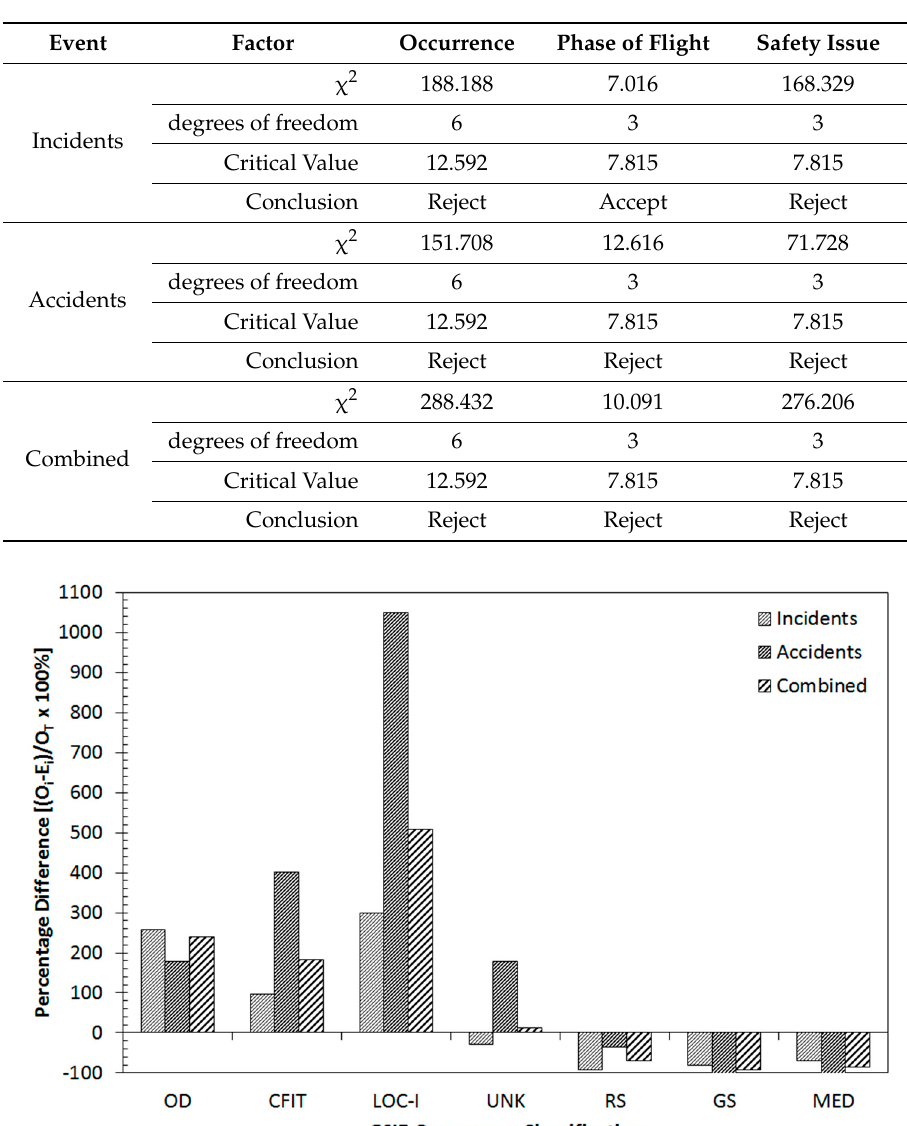
Table 1. Outputs from Pearson’s chi squared test for goodness of fit, for each of the three factors (occurrence, phase of flight, and safety issue), testing the distribution of incidents, accidents, and the combined total number of events.